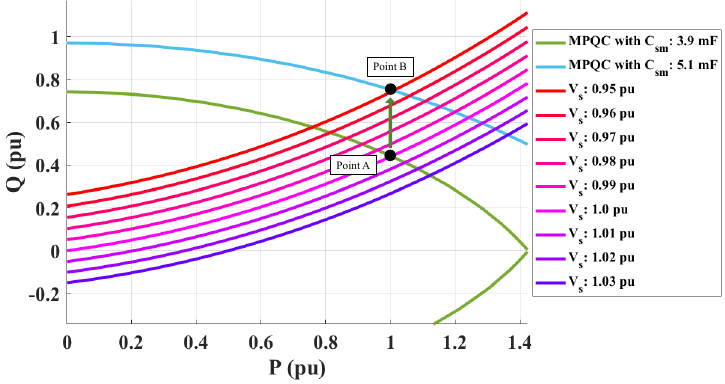
Figure 14. Different PQ loading curves of MMC in MILM case under different system voltages.